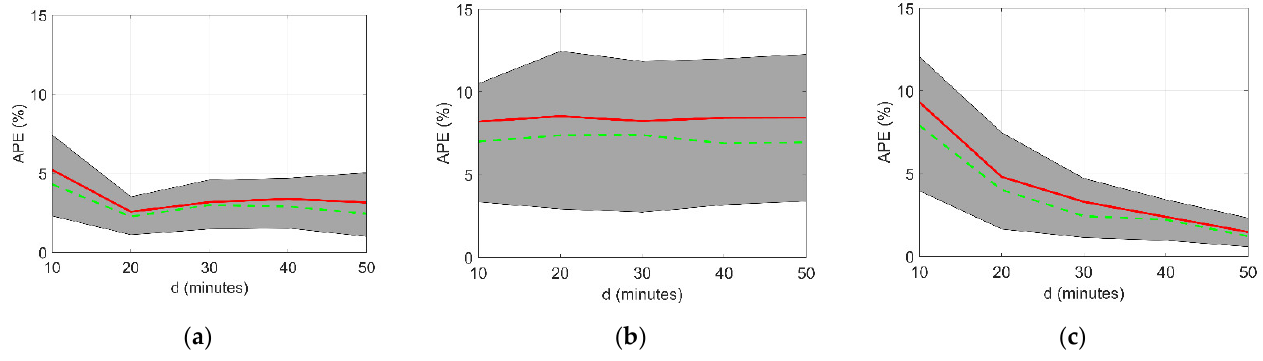
Figure 3. Comparison between absolute percentage errors of the mean maximum rainfall estimates at sub-hourly durations d obtained by: ( a ) exploiting the 10-minute resolution database, i.e., the best estimate approach; ( b ) kriging interpolation; and ( c ) using the new proposed hybrid regional approach. The red line shows the mean error over the region, the green dotted line represents the median value, and the grey area is delimited by the 25th and 75th percentiles along the 160 automatic stations in the region.